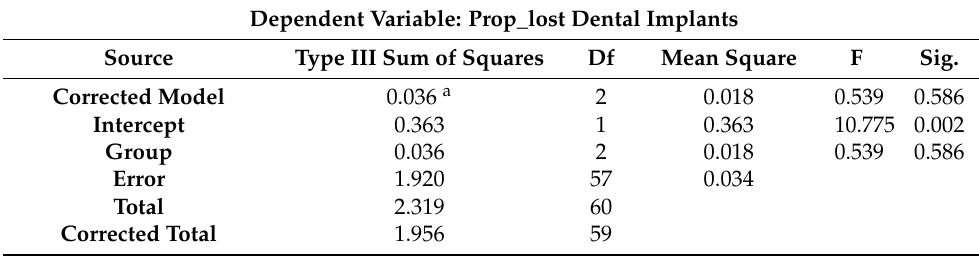
Table 4. Differences among groups in terms of the proportion of lost implants.